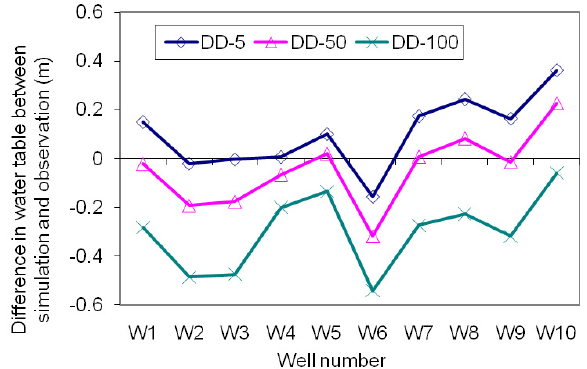
Fig.5. Differences between observed and simulated water table depth under different drainage Fig. 5. Differences between observed and simulated water table depth in calibration. The curves marked by DD-5, DD-50 and DD-100 represent drainage depth depth under different drainage depth in calibration. The curves of 5, 50 and 100 cm. marked by DD-5, DD-50 and DD-100 represent drainage depth of 5, 50 and 100cm. 1